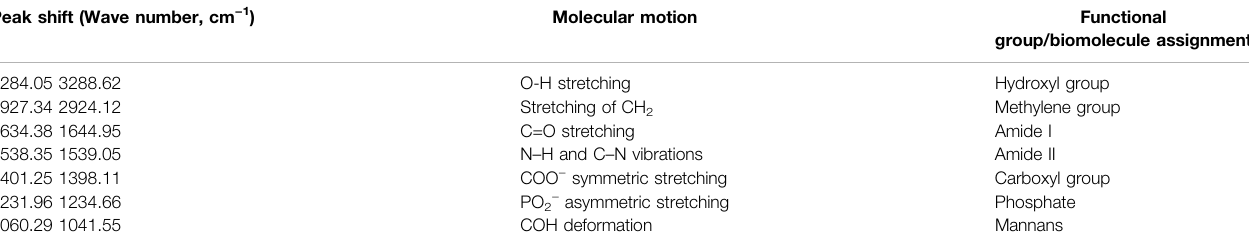
TABLE 2 | The functional groups possibly involved in the binding of ZnO NPs onto the cell wall of E. faecalis